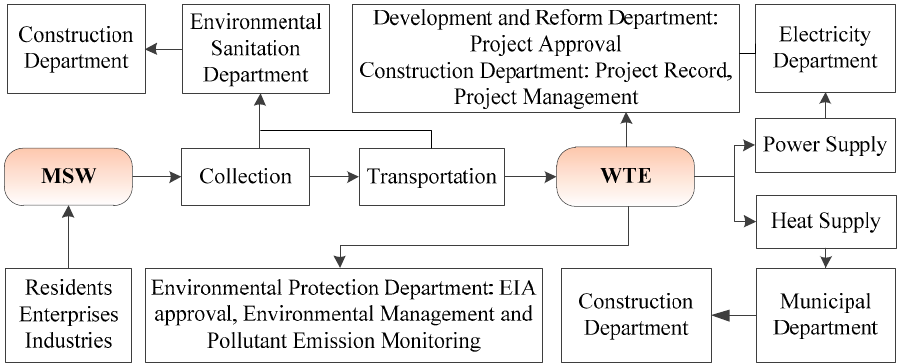
Figure 4. The procedure of a waste-to-energy (WTE) facility and the corresponding government authorities.